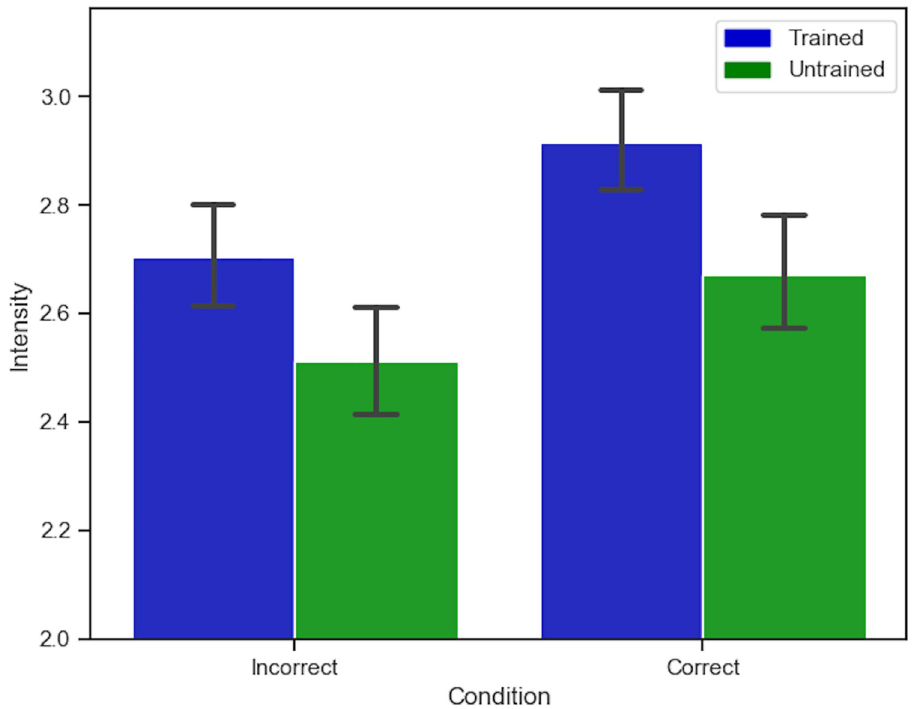
Fig 4. Accuracy and intensity results. Effects of Groups and Emotion Recognition Accuracy on Perceived Emotion Intensity. Y-axis represents a truncated scale, and error bars represent 95% confidence intervals.